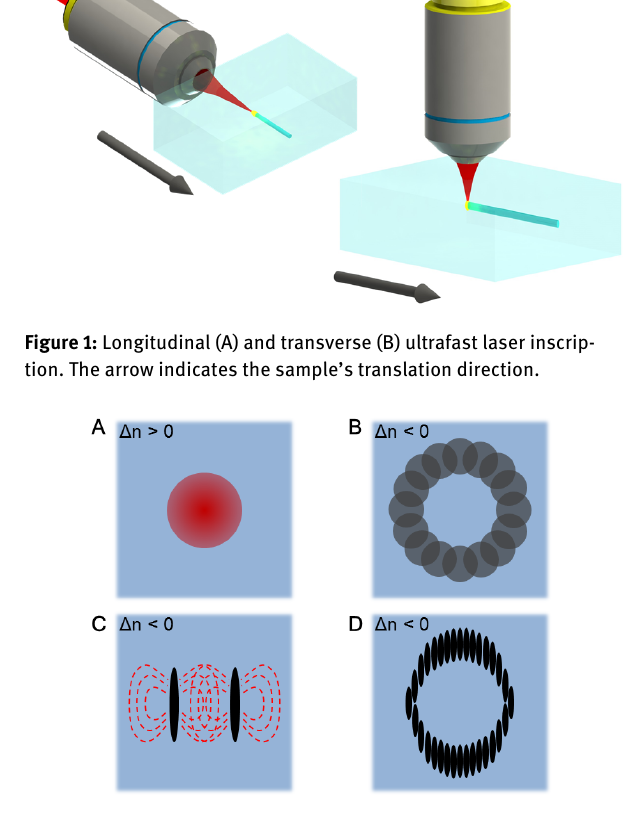
Figure 2: Waveguide geometries in glass and crystals. (A) Waveg- uide with a positive index contrast based on a smooth Type I mod- ification. (B) Depressed cladding waveguide created from partially overlapping Type I modifications surrounding an unmodified core. (C) Stress-induced waveguide in crystals based on two parallel Type II tracks. The guided mode is located in between the two damage lines. The anisotropic stress-field, indicated by the red-dashed lines, typically only guides a single polarization. (D) Depressed cladding geometry based on Type II modifications in